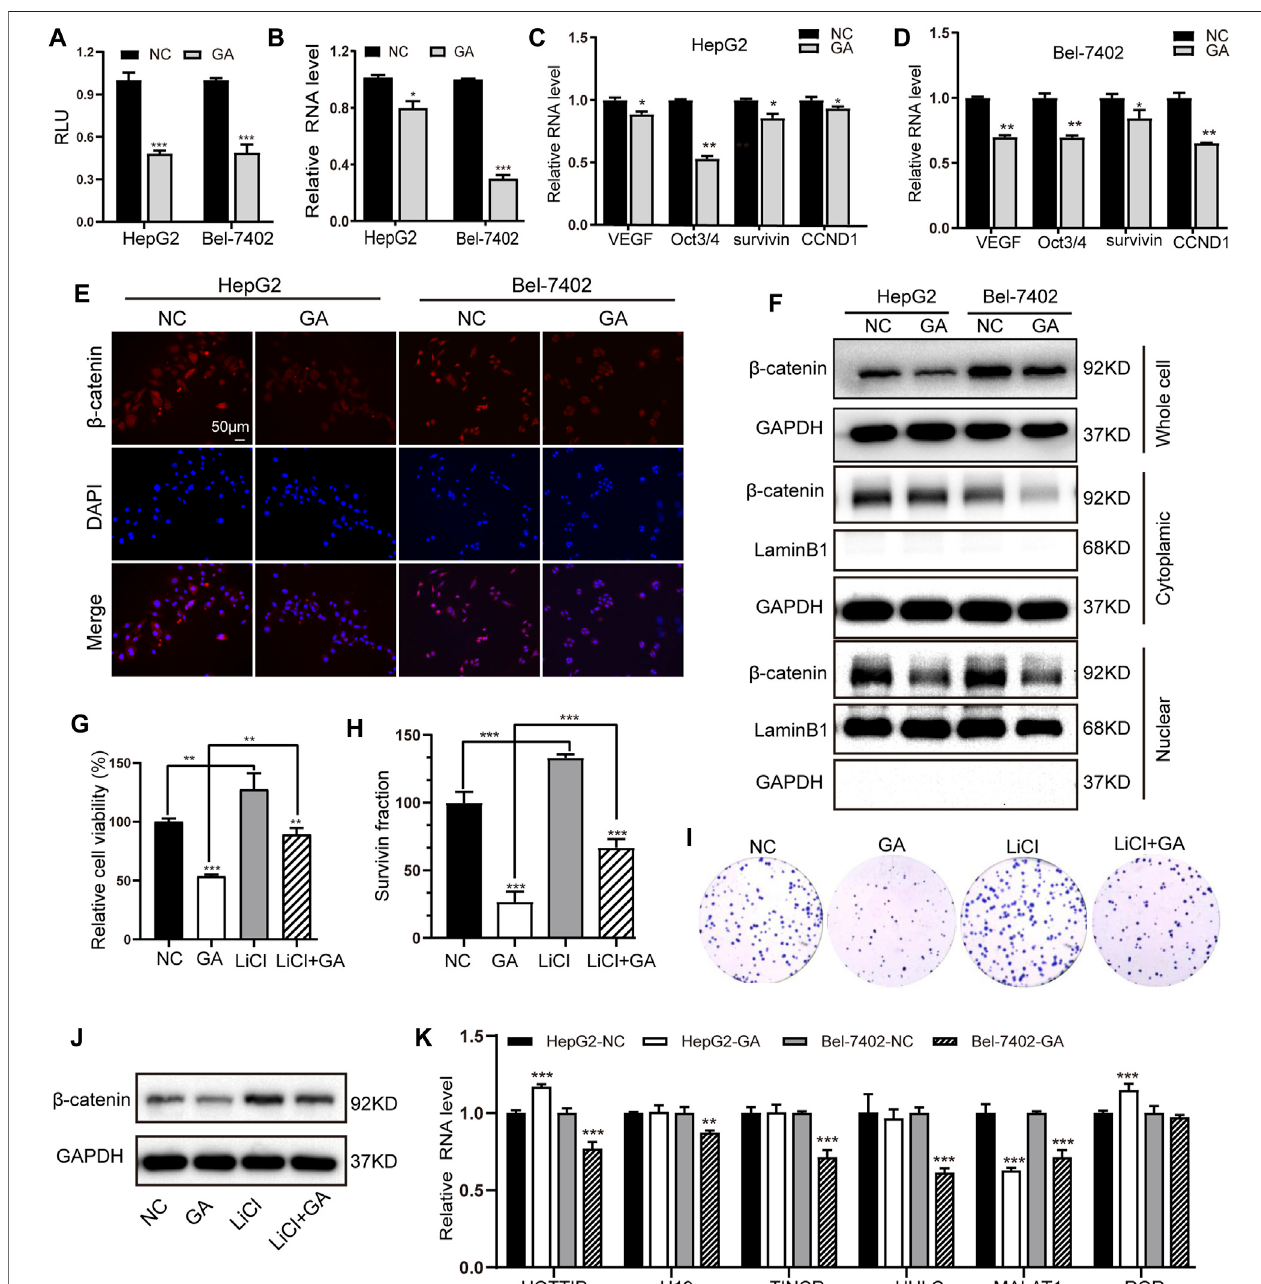
FIGURE 4| GA induced the inactivation ofWnt/ β -catenin signaling and depressionof MALAT in HCC cells. (A) After transfection with TOP fl ash luciferase reporter, the two HCC cells were treated with 120 μ M GA for 48 h. The luciferase activities were measured. (B) The mRNA expression of β -catenin in GA-treated cells were examined by q-RT-PCR. (C,D) The expression of several downstream targets of Wnt/ β -catenin pathway were examined by qPCR assays. (E) The expression of β -cateninwasdetectedbyimmuno fl uorescencestaining. (F) Theproteinleveloftotal β -catenin,intracytoplasmic β -cateninandintranuclear β -catenininGA-treated cells were determined by Western blotting. Cell viabilities (G) and colony formation (H,I) was measured after treatment of LiCl and GA. (J) The protein level of total β -catenin were determined by Western blotting after treatment of LiCl and GA. (k) The two HCC cell lines were incubated with GA for 48 h, RNA expression of chosen lncRNAs were determined by qRT-PCR assays. *, p < 0.05; **, p < 0.01; ***, p < 0.001; vs NC.